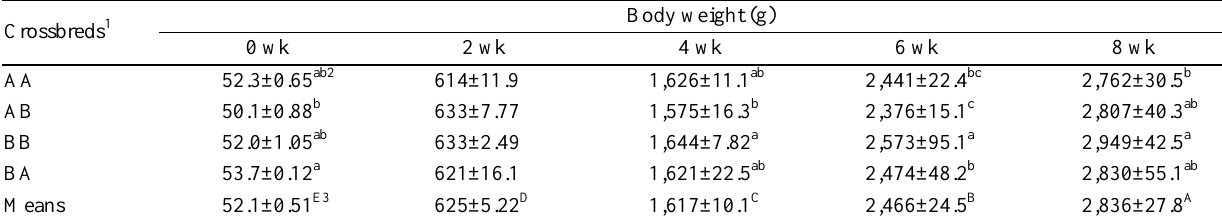
Table 3. Average body weight of commercial Korean native ducks during the experimental period Crossbreds 1